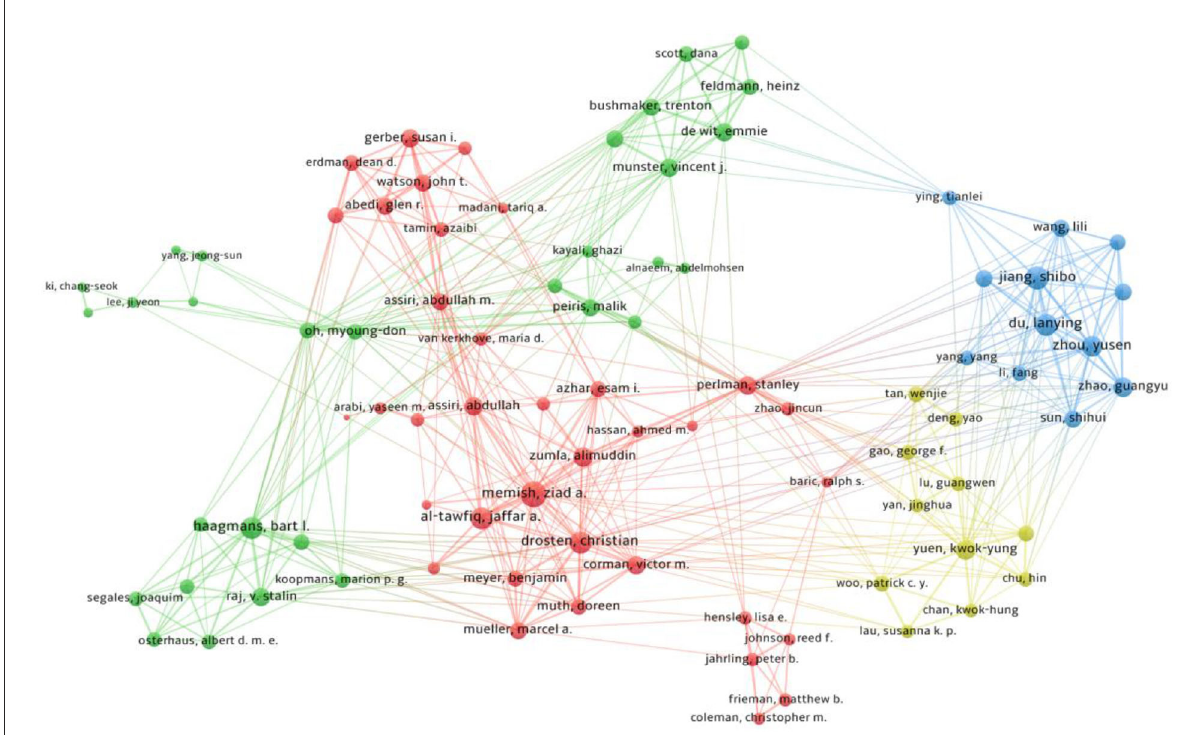
FIGURE4 A co-authorship author network visualization map based on total link strength. The thicker the line among the authors, the stronger the collaboration, while the bigger the node, the greatest the contribution